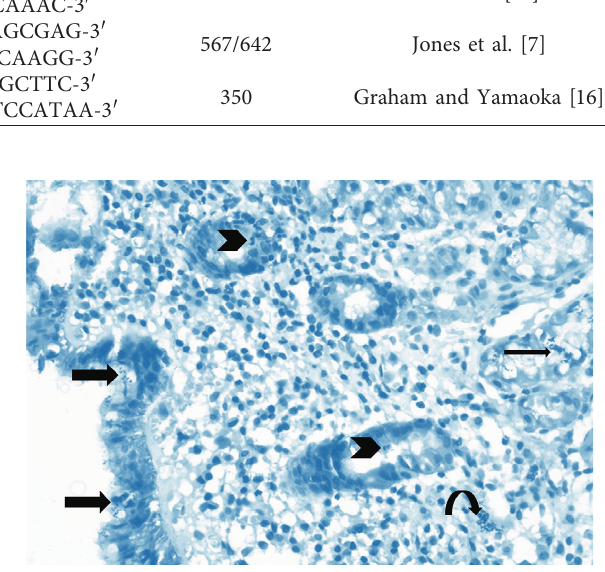
Figure 3: Photomicrograph showing chronic superficial active gastritis (arrow heads pointing to neutrophils attacking glandular epithelium), with mixed inflammatory cell infiltrate, mainly lym- phocytes and plasma cells. Helicobacter pylori are present in the superficial mucous layer (thick arrow), within the glands, and in the lamina propria (curved arrow), Giemsa stain, × 200.